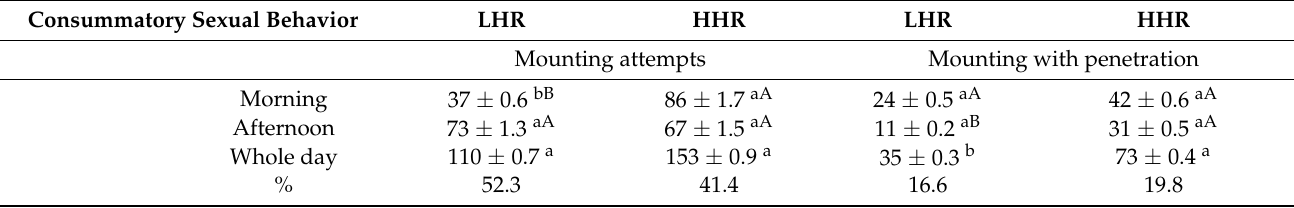
Table 5. Consummatory sexual behavior in Dorper rams (CSB; n = 8) of low (LHR) or high social hierarchy (HHR) during the morning and afternoon, during the non-breeding